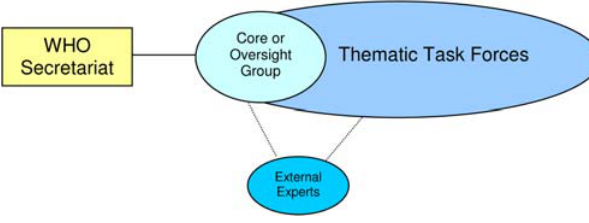
Figure 1. Composition and Structure of the Foodborne Disease Burden Epidemiology Reference Group (FERG)